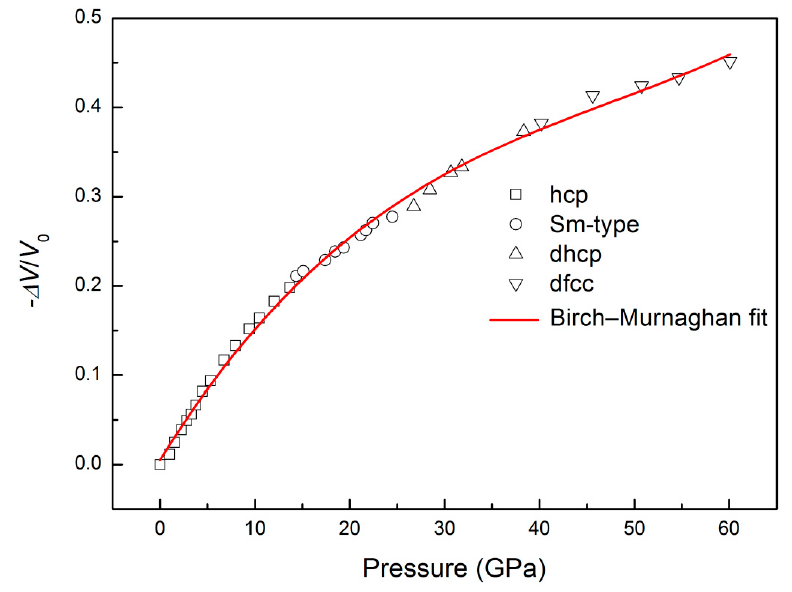
Figure 7. The measured pressure-volume relationship for various phases of the HoDyYGdTb high-entropy alloy (HEA) at up to 60.1 GPa, at room temperature, data from [47]. Gong Li et al. [57] studied the pressure-volume relationship of CoCrFeNiAlCu HEA using in-situ high-pressure energy-dispersive X-ray di ff raction with synchrotron radiation at high pressures, and the results show that the CoCrFeNiAlCu HEA keeps a stable fcc + bcc structure in the experimental pressure ranges from 0 to 24 GPa. The equation of the state of the HEA determined by the calculation of the radial distribution function in the non-phase-transitional case is: = 2.7 P − 0.256 P 2 + 0.012 P 3 − 2.928 × 10 − 4 P 4 + 2.907 × 10 − 6 P − ∆ V / V 0